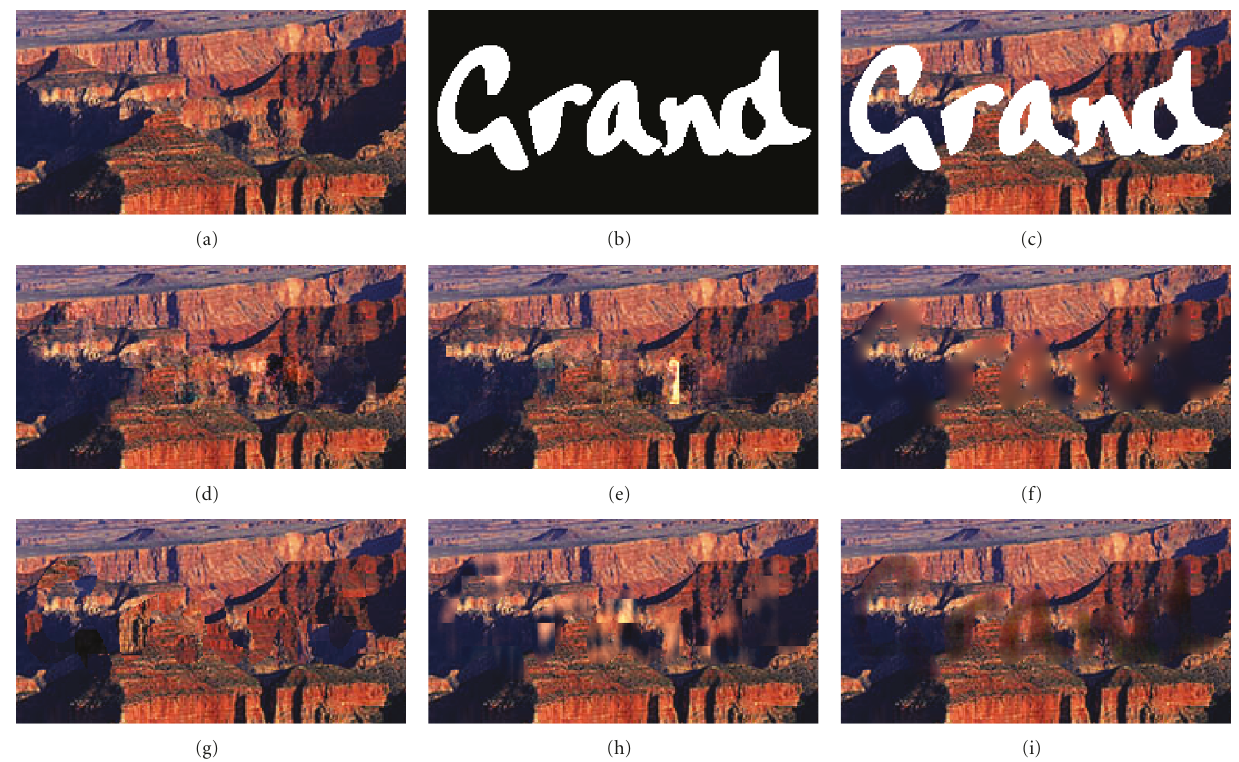
Figure 3: (a) Zoomed portion of Figure 2(a). (b) Zoomed portion of Figure 2(b), (c) Zoomed portion of Figure 2(c), (d) Zoomed portion of Figure 2(d), (e) Zoomed portion of Figure 2(e), (f) Zoomed portion of Figure 2(f), (g) Zoomed portion of Figure 2(g), (h) Zoomed portion of Figure 2(h), (i) Zoomed portion of Figure